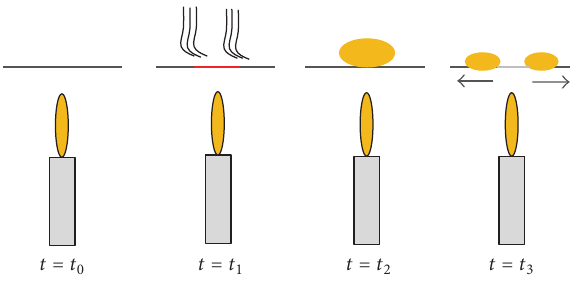
Figure 11: Schematic view of incense stick kept vertically at various time instants “ 𝑡 ”; 𝑡 3 > 𝑡 2 > 𝑡 1 > 𝑡 0